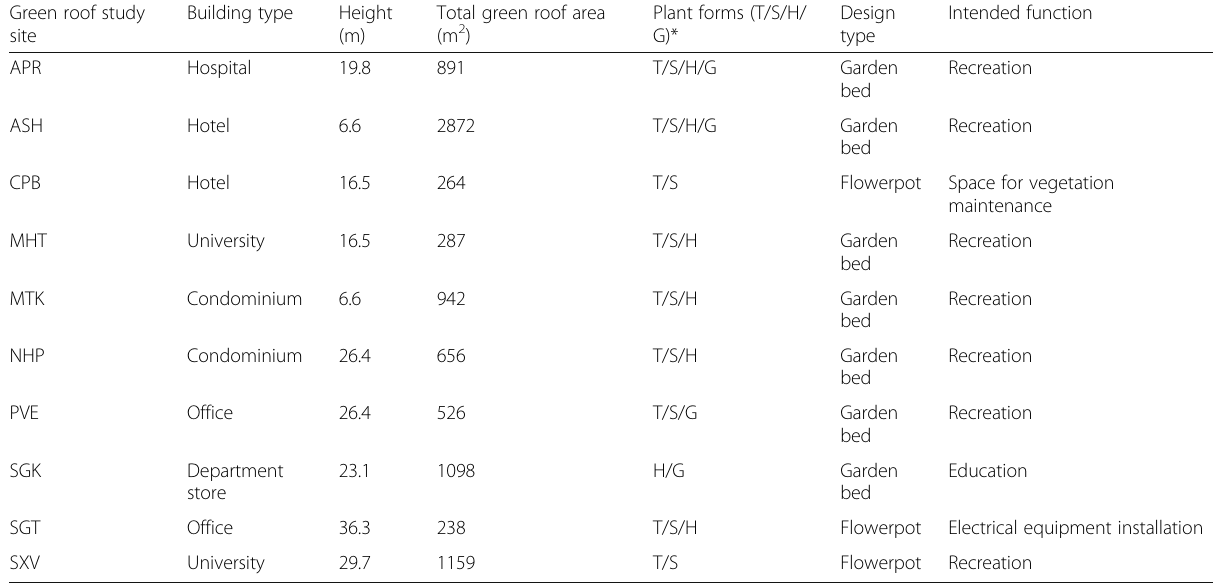
Table 1 General characteristics of the ten green roofs used in this study Green roof study